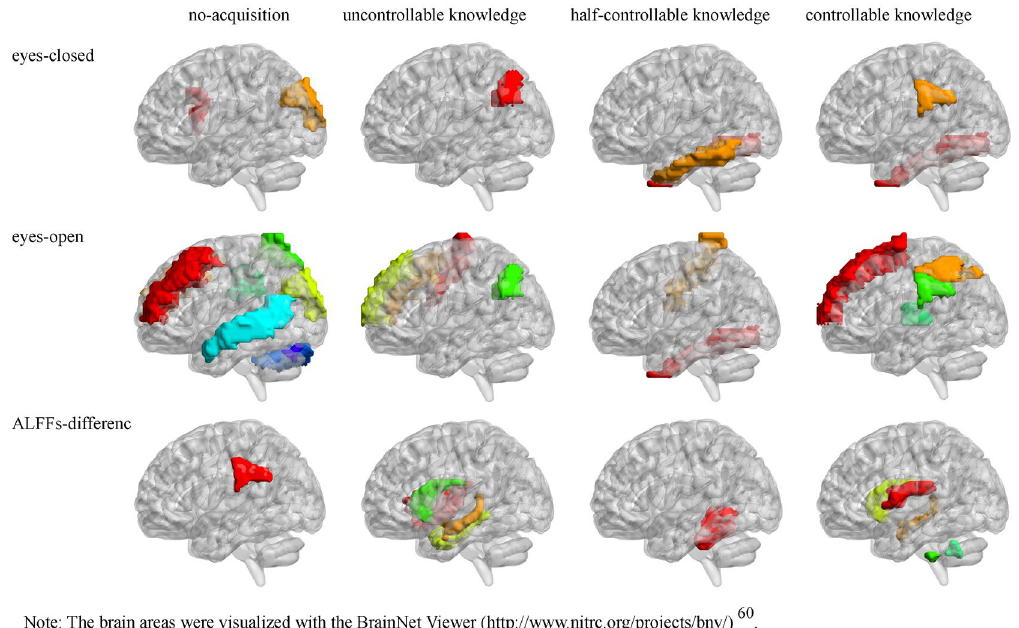
Figure 2. AAL brain areas whose ALFFs/ALFFs-difference were related to the four MET knowledge. Note : The brain areas were visualized with the BrainNet Viewer (http:// www. nitrc. org/ proje cts/ bnv/) 60